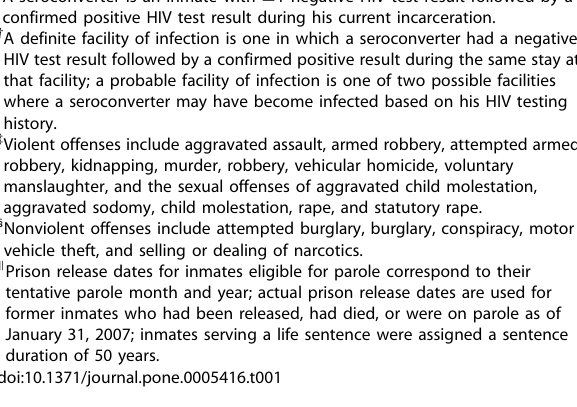
(Figure 1). Seroconverters had a median of one negative HIV test result during incarceration (range: 1–7 negative tests); their first negative result was a median of 214 days (range: 7–4576 days) after the start of incarceration. The median duration from start of incarceration to HIV diagnosis was 8 years (range: 1–21 years). Of 47 seroconverters with a single negative HIV test result during incarceration, 26 (55%) were tested more than180 days after the